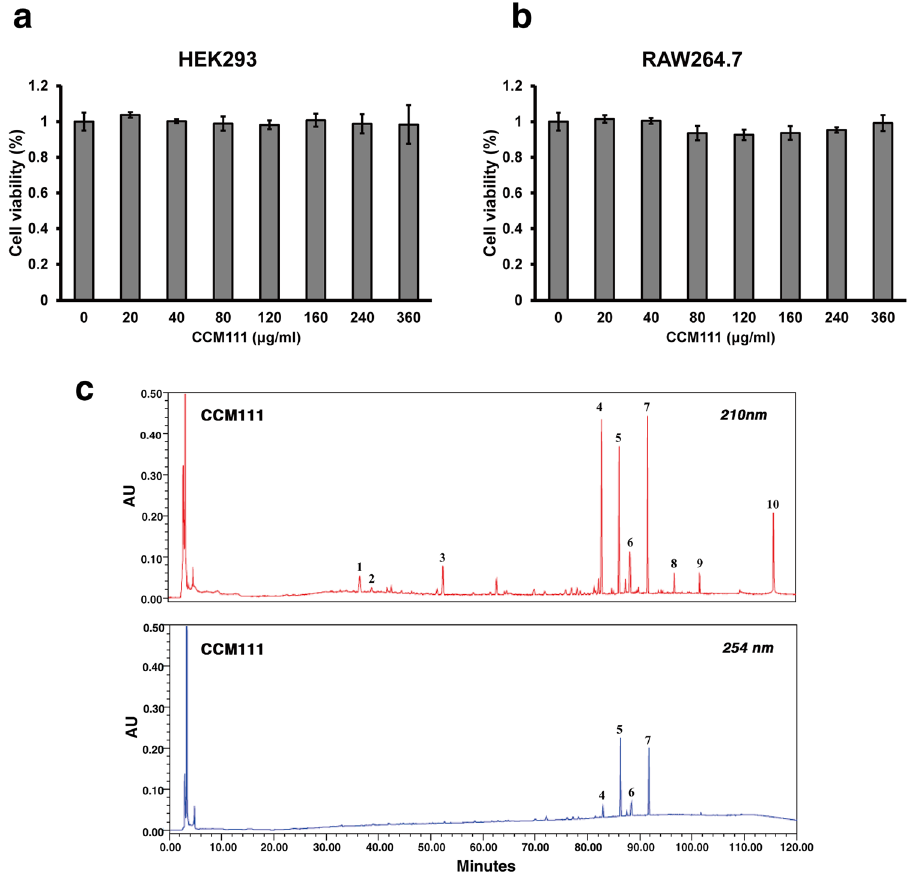
Figure 1. Toxicity of CCM111 and chemical fingerprint analysis of CCM111 by HPLC-UV. ( a ) and ( b ) HEK293 or RAW264.7 cells were treated separately with different concentrations of CCM111 (0, 20, 40, 80, 120, 160, 240, and 360 μ g/ml) for 24 hours. The survival of cells was detected by the Alamar blue assay. Results were obtained from three independent replicates. ( c ) The HPLC-UV method was performed to establish the quality control of CCM111. The absorption of UV wavelengths was measured at 210 nm and 254